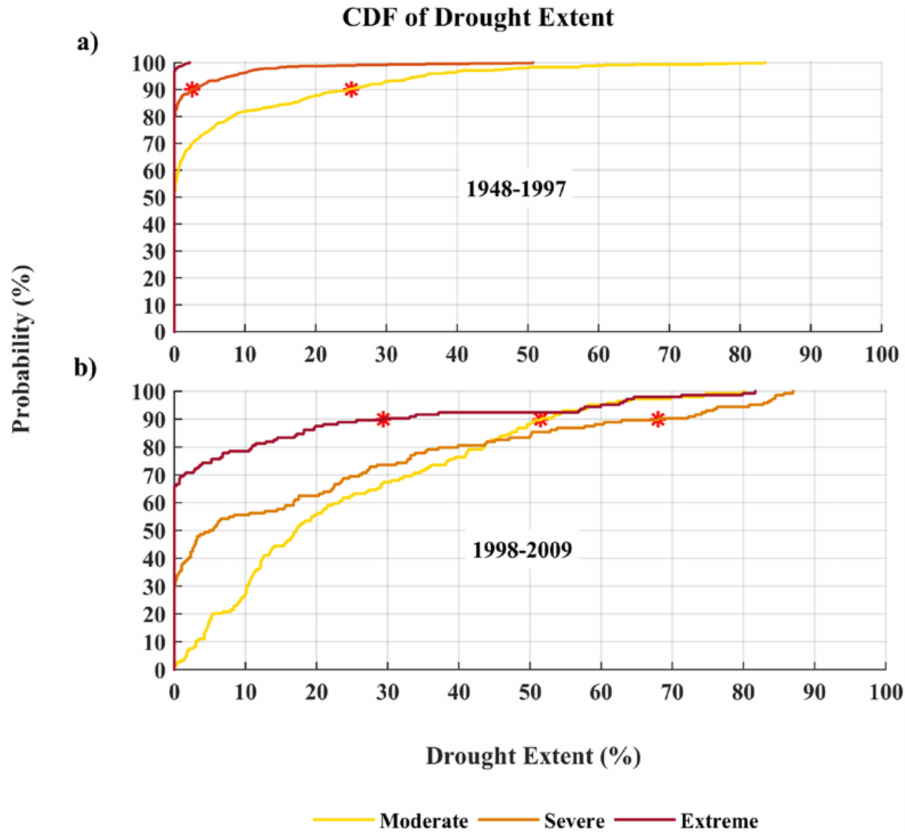
Figure 4. Probability of drought extent based on 12-month SPEI over Iraq for two periods: ( a ) 1948–1997, ( b )